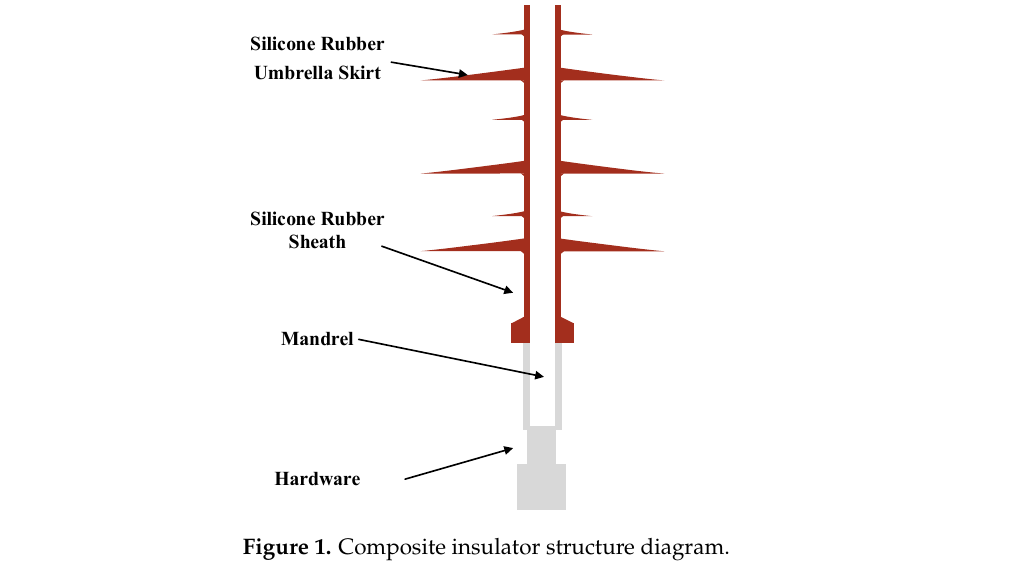
Figure 1. Composite insulator structure diagram.